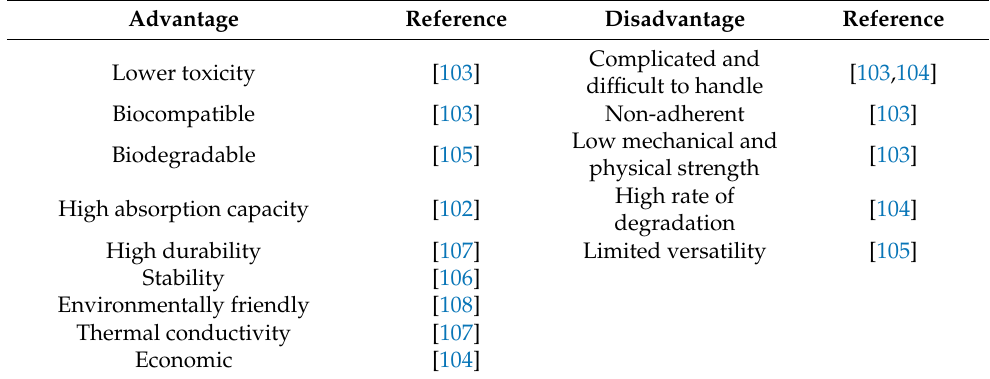
Table 2. Advantages and disadvantages of using adsorption for hydrogels based on chitosan or alginate.